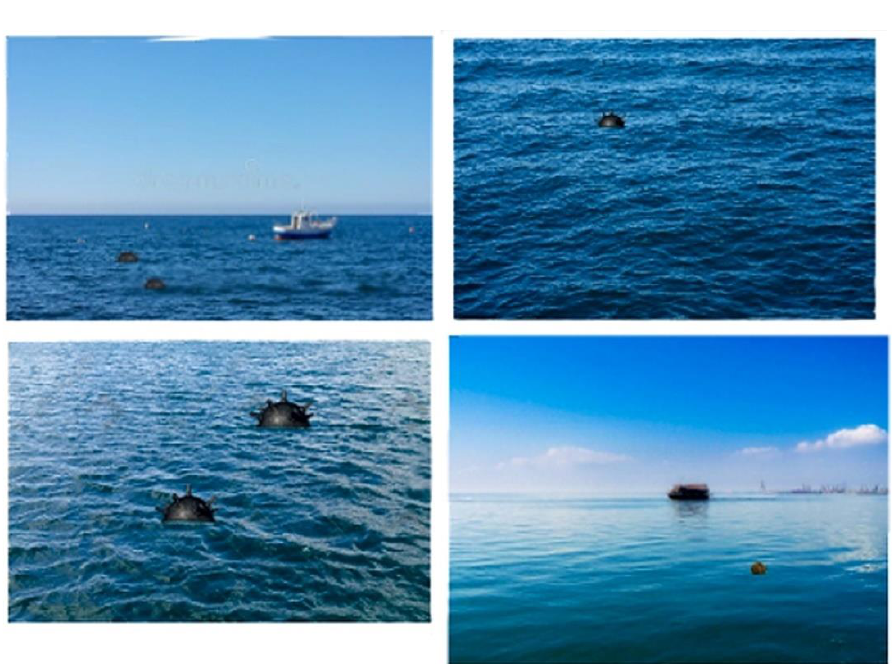
Figure 8. Synthetic images with floating mines.